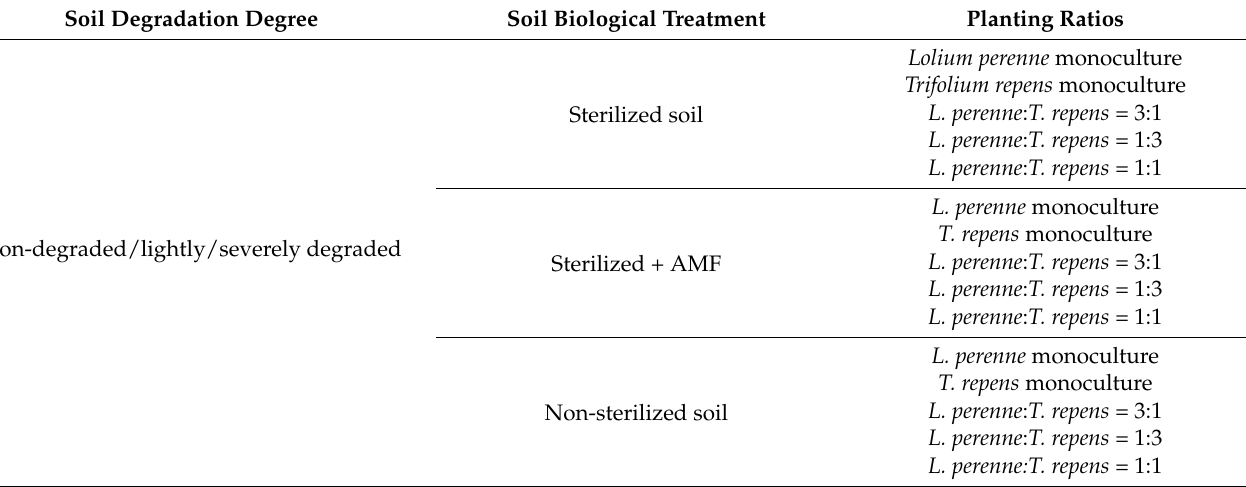
Table 1. A complete factorial design of 3 levels of soil degradation degree × 3 levels of soil biological treatment × 5 levels of plant